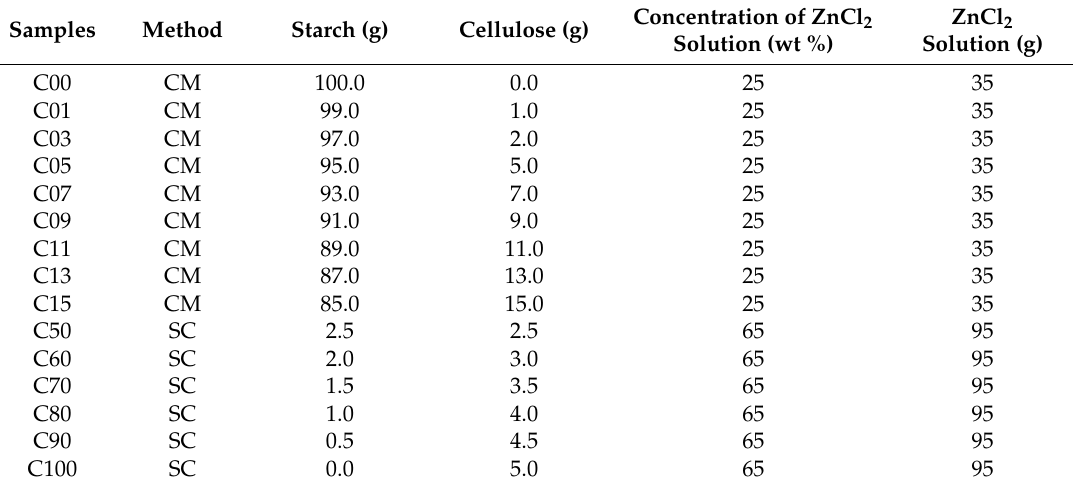
Table 1. Sample formulations of the cellulose-starch hybrid